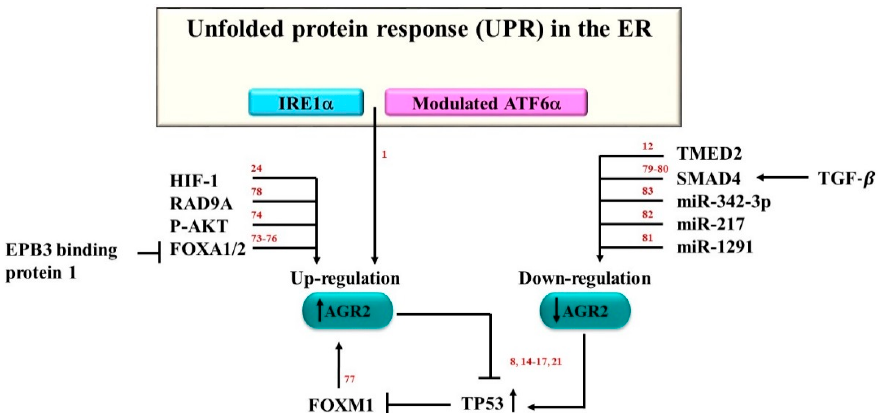
Figure 2. The expression of AGR2 is regulated by multiple proteins. IRE1 α , modulated ATF6 α , HIF-1 α , RAD9A, phosphorylated-AKT, FOXA1 / 2 have all been shown to contribute to the upregulation of AGR2. In contrast, the upregulation of SMAD4, miR-342-3p, miR-217, miR-1291, and TMED2 have been shown to contribute to the downregulation of AGR2. While p53, and FoxM1 appear to be involved in a feedback regulatory loop. The numbers in red indicate references.